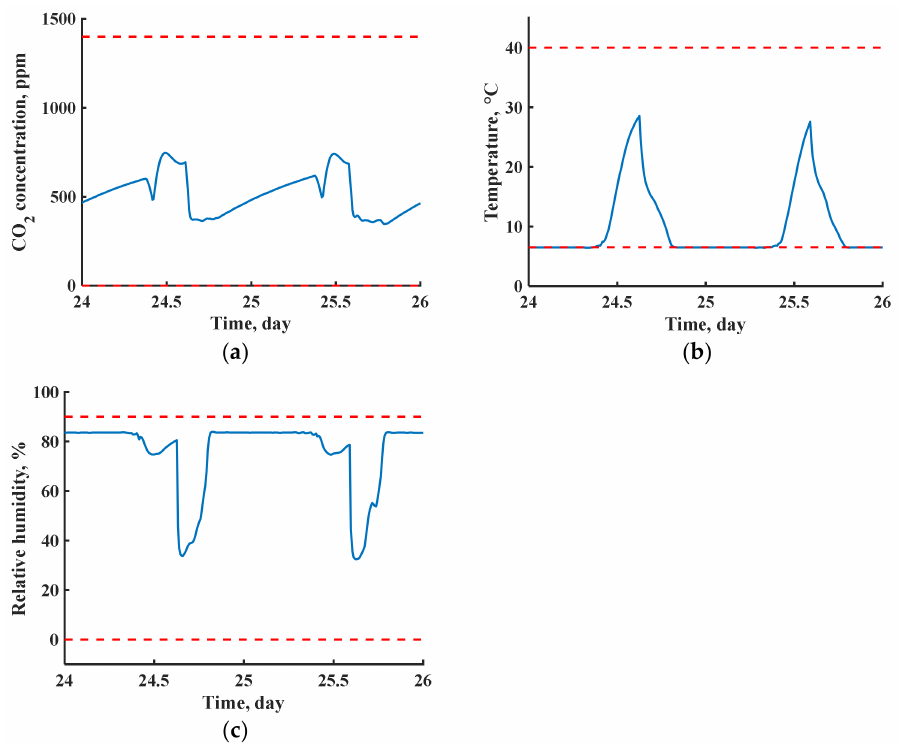
Figure 6. Greenhouse climate during 2 days. ( a ) Internal CO 2 concentration, ( b ) Internal temperature, ( c ) Internal relative humidity.